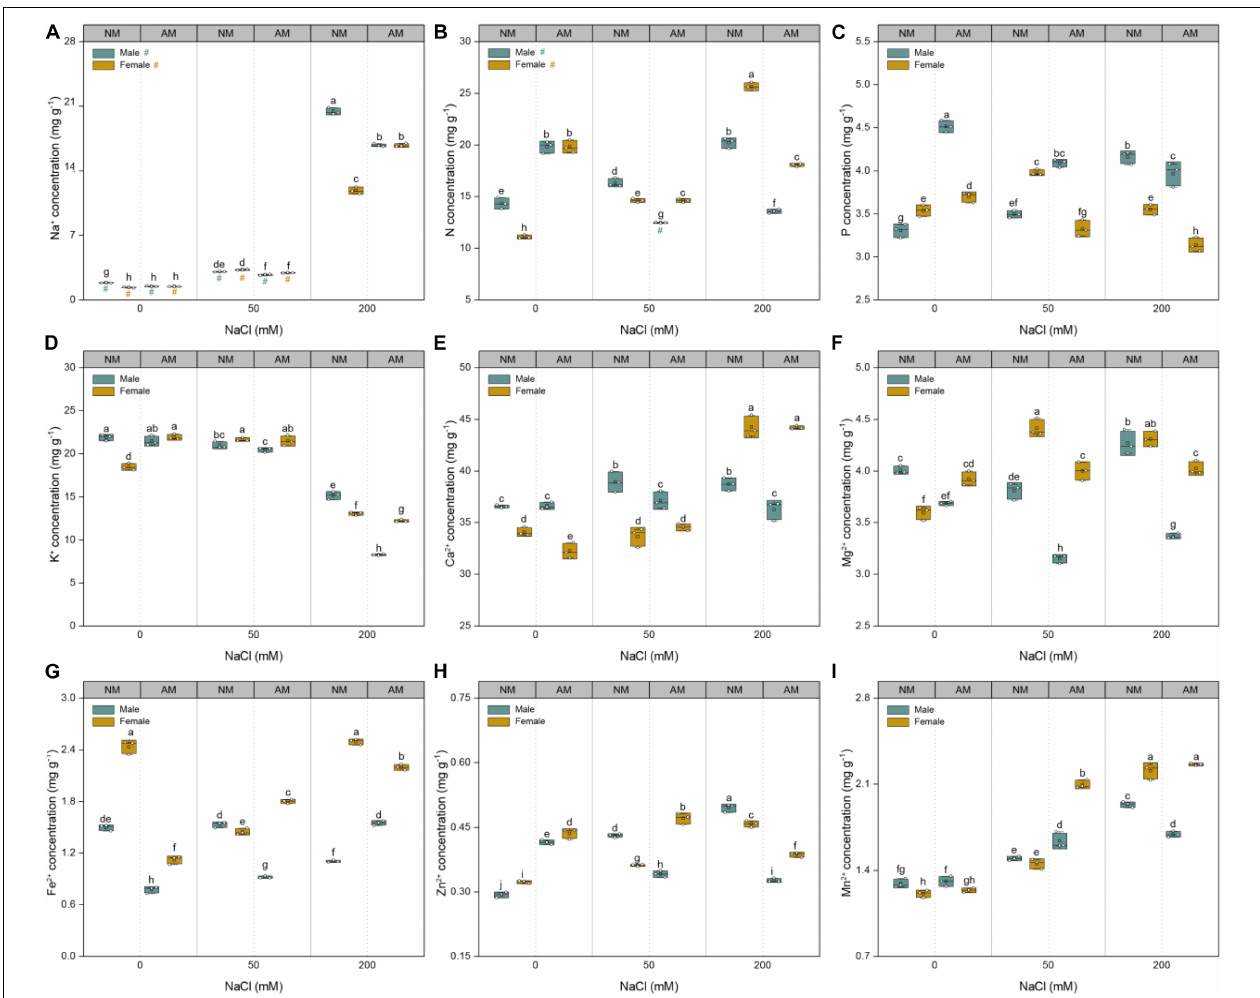
FIGURE 5 | Effects of arbuscular mycorrhizal fungus on Na + (A) , N (B) , P (C) , K + (D) , Ca 2 + (E) , Mg 2 + (F) , Fe 2 + (G) , Zn 2 + (H) , and Mn 2 + (I) of whole plant in males and females of Morus alba under saline conditions. NM and AM represent inoculation with no mycorrhizal fungi and with Funneliformis mosseae , respectively. Bars represent means ± SD ( n = 3). Three-way ANOVA is performed to compare the effects of sex, salt, and AM inoculation and their interactions in both males and females. Different letters indicate a significant difference according to least significant difference at p <